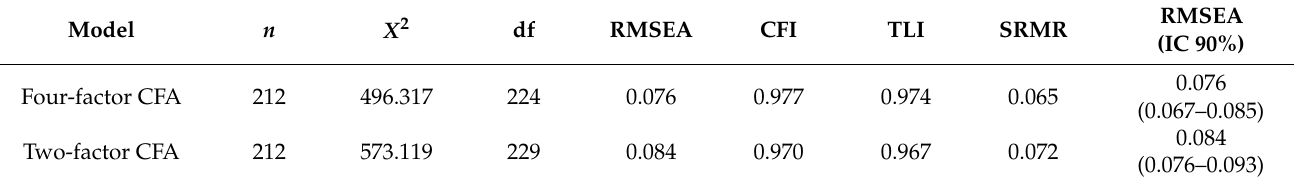
Table 3. Fit indices pertaining to the confirmatory factor analytic